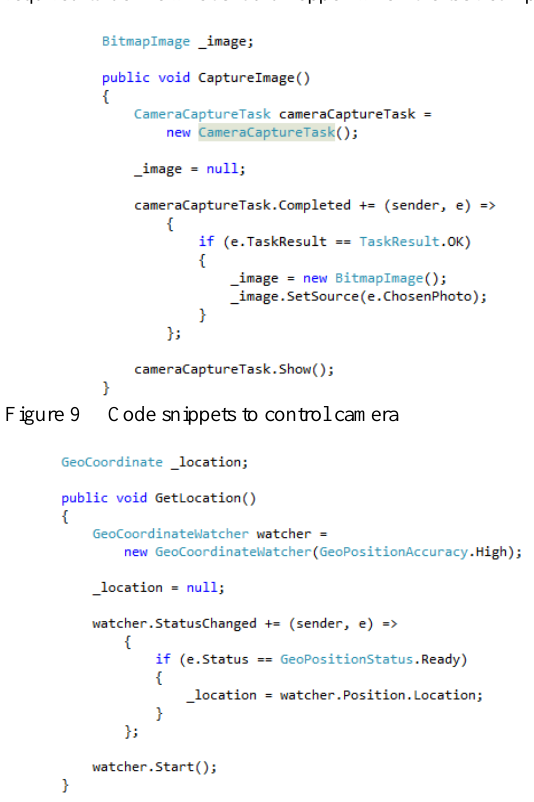
Figure 10 Code snippet to obtain geographic coordinates from the location API